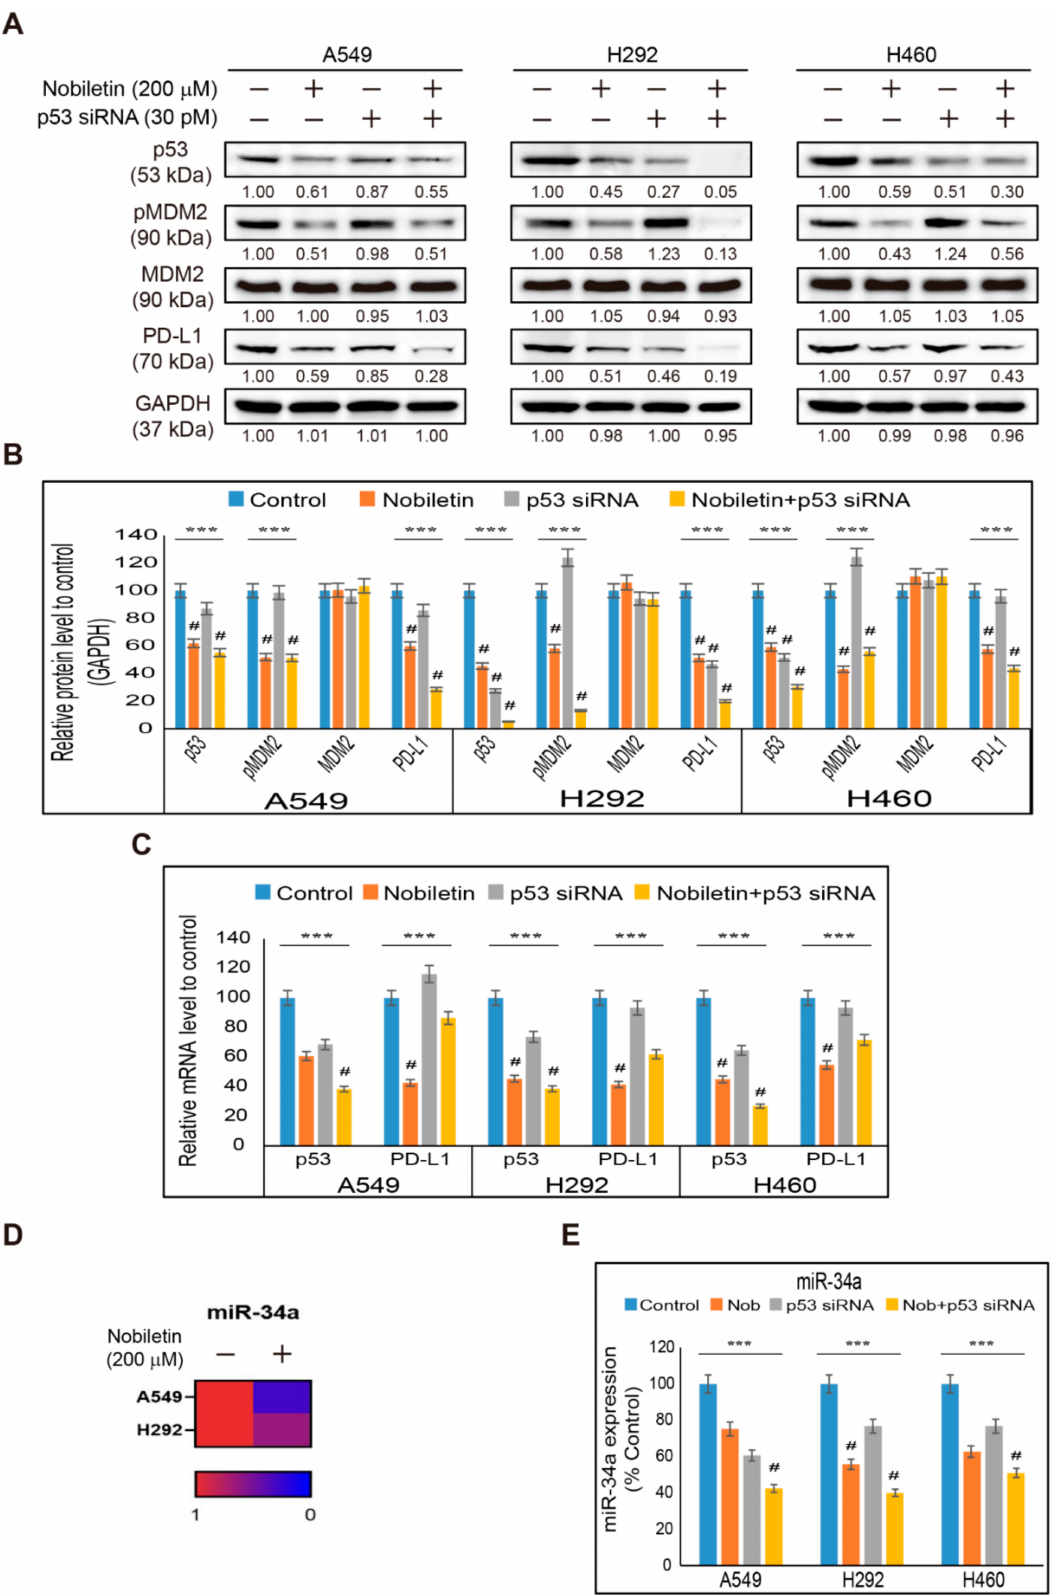
Figure 5. p53-Independent inhibition of PD-L1 by nobiletin. ( A ) Western blotting analysis of A549, H292, and H460 cells pretreated with p53 siRNA (30 pM) for 24 h, then treated with 200 µ M nobiletin for 48 h shows the expression patterns of p53, MDM2, pMDM2, and PD-L1 proteins. ( B ) Representative expression of proteins was quantified by